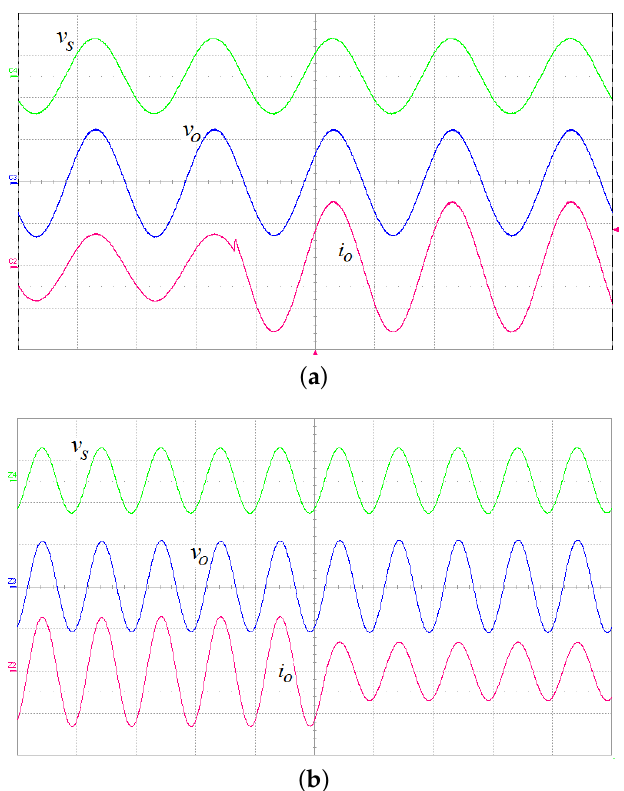
Figure 22. v s , v o and i o waveform: v s (0.5 Volt/div), v o (10 volt/div), i o (2 amp/div). ( a ) Incremen- tal loading of amplifier, timescale: (500 micro-second/div). ( b ) Decremental loading of amplifier, timescale: (1 milli-second/div).